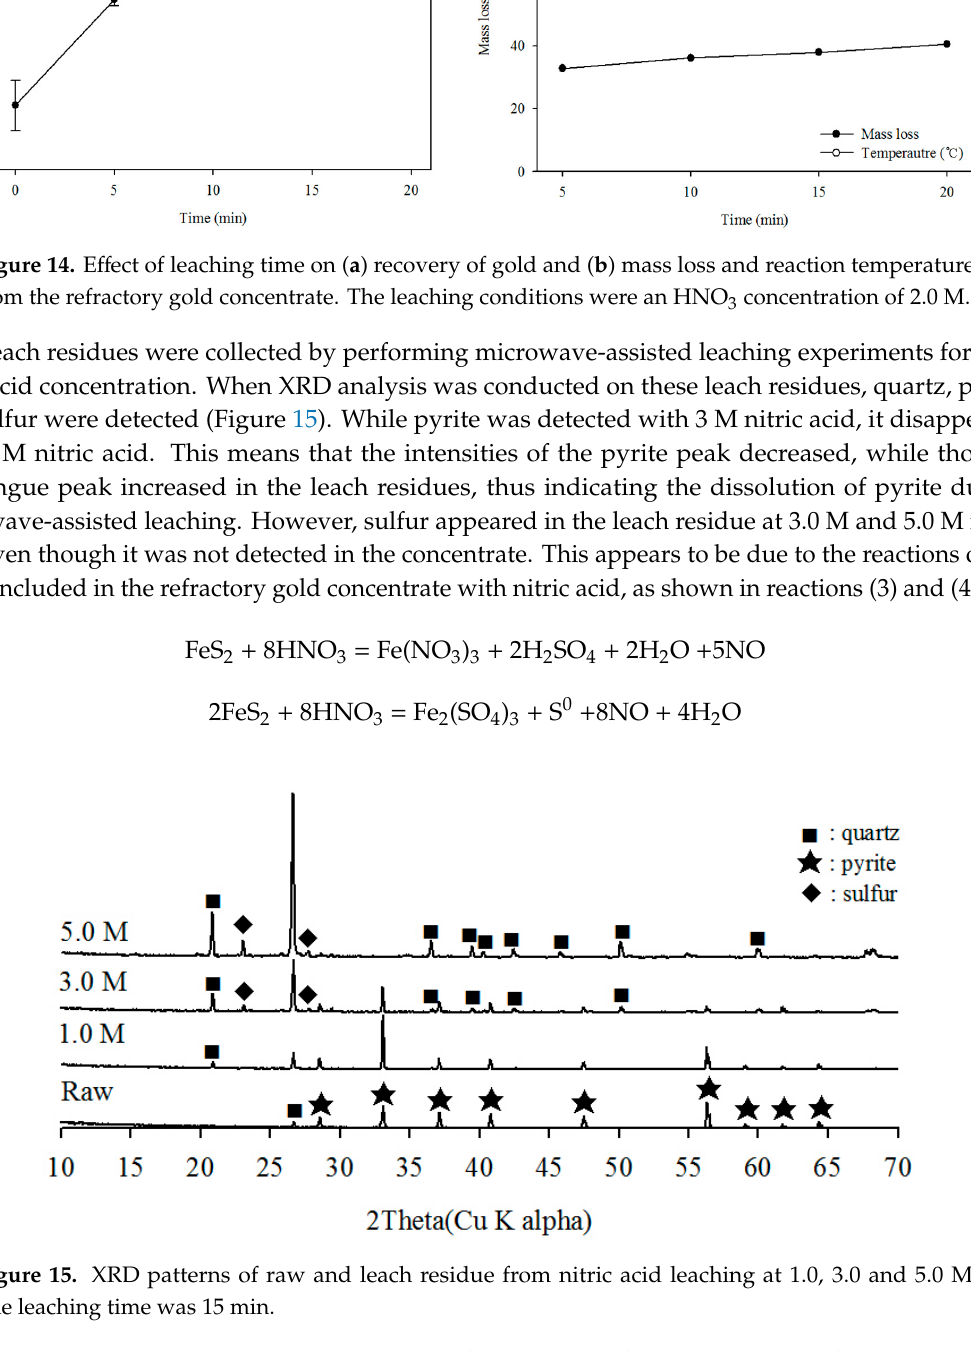
Figure 16. SEM images of the leach residues from nitric acid leaching at (a) 1.0 M, (b) 3.0 M and (c) 5.0 M. The leaching time was 15 min. 4. Conclusions The leaching efficiencies of metal ions (As, Cu, Zn, Fe, and Pb) and the recovery of gold from the refractory gold concentrate were investigated using a microwave system. As the acid concentration increased, the metal ion leaching increased, but the leach residues for the low nitric acid concentration (> 0.5 M) consisted mainly of untreated pyrite. The S/Fe ratio determines the surface of the leach residue, which affects the efficiency of passive layer removal. S/Fe ratio in nitric acid leaching with a reaction time of 10 min reached 4.34 at 0.1 M and 4.20 at 0.5 M. It was found that a relatively lower proportion of iron was consumed, and the pyrite in the refractory gold concentrate did not significantly dissolve during nitric acid leaching at > 0.5 M.